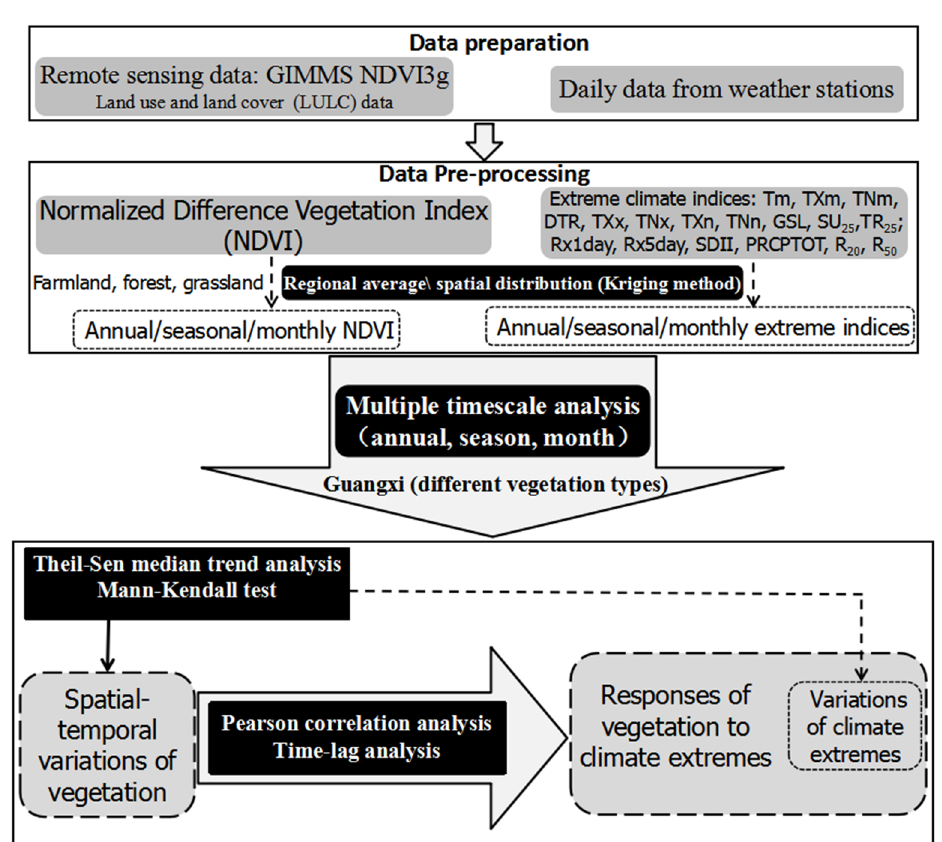
Figure 2. Flowchart of monitoring changes in vegetation dynamics and relations with extreme cli- mate.